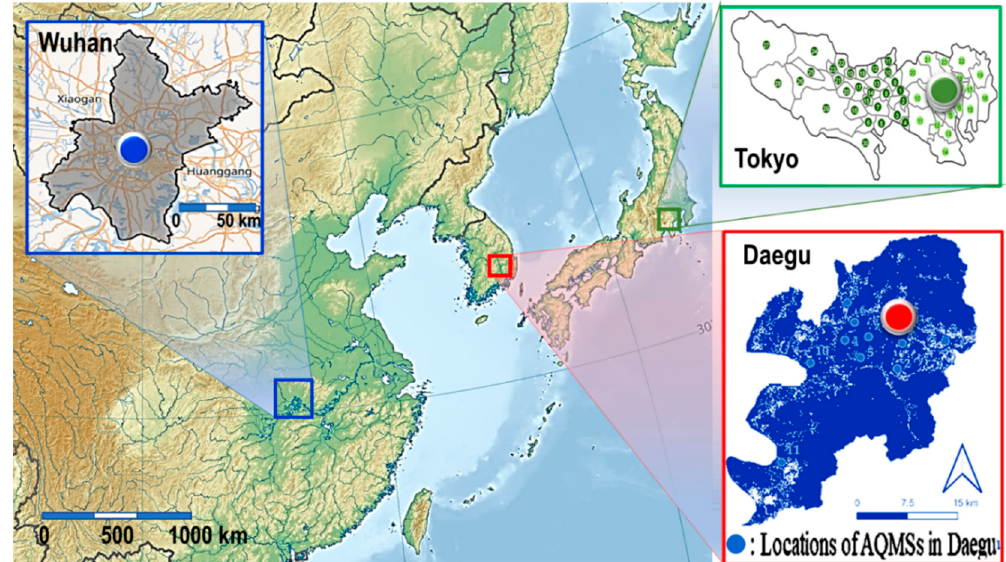
Figure 1. The maps of Wuhan, Daegu, and Tokyo and the locations of air pollution monitoring stations (AQMS) in each city.